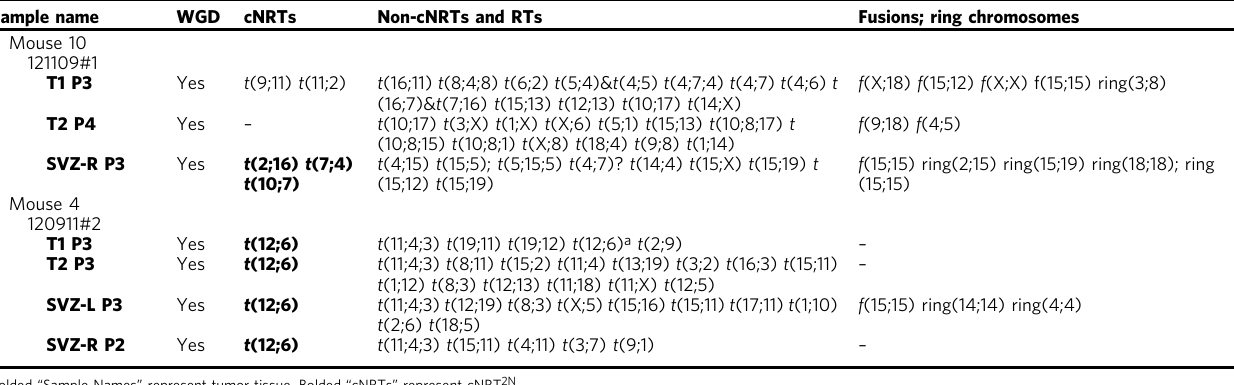
Bolded “ Sample Names ” represent tumor tissue. Bolded “ cNRTs ” represent cNRT 2N a These NRTs potentially have different breakpoints compared to the cNRTs in that